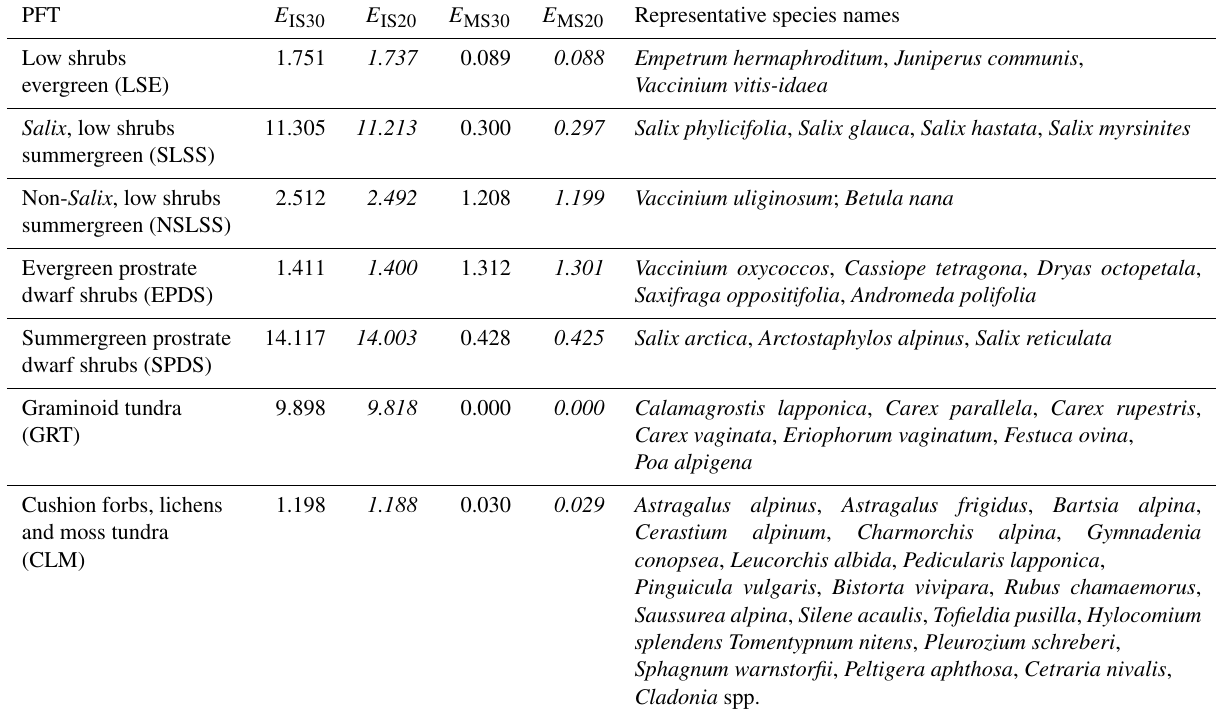
Table 1. Plant functional types (PFTs) and representative species in the study area. The emission capacity of isoprene ( E IS , µg Cgdw − 1 h − 1 ) and monoterpenes ( E MS , µg Cgdw − 1 h − 1 ) at 20 ◦ C (in italics) used the adjusted temperature response curve from this study, whilst the averaged literature values of the emission capacity at 30 ◦ C were based on the Guenther’s algorithms. The values are based on the available growing season leaf-level measurements from the